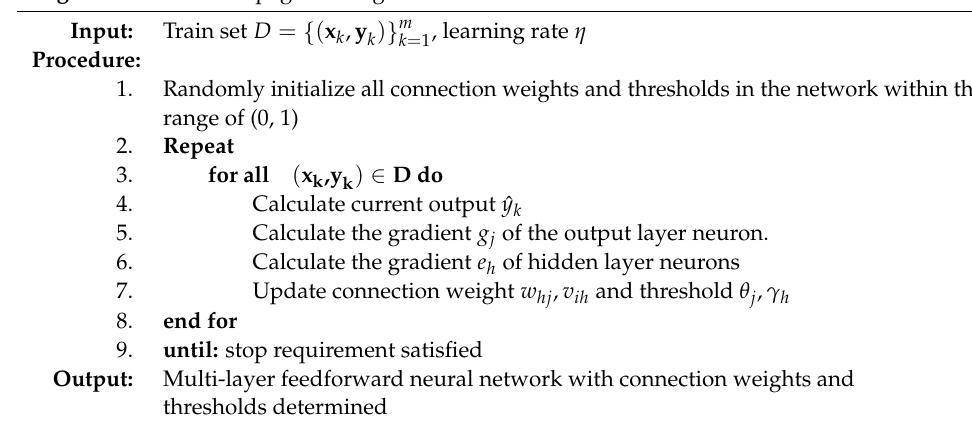
Algorithm 1. Back Propagation